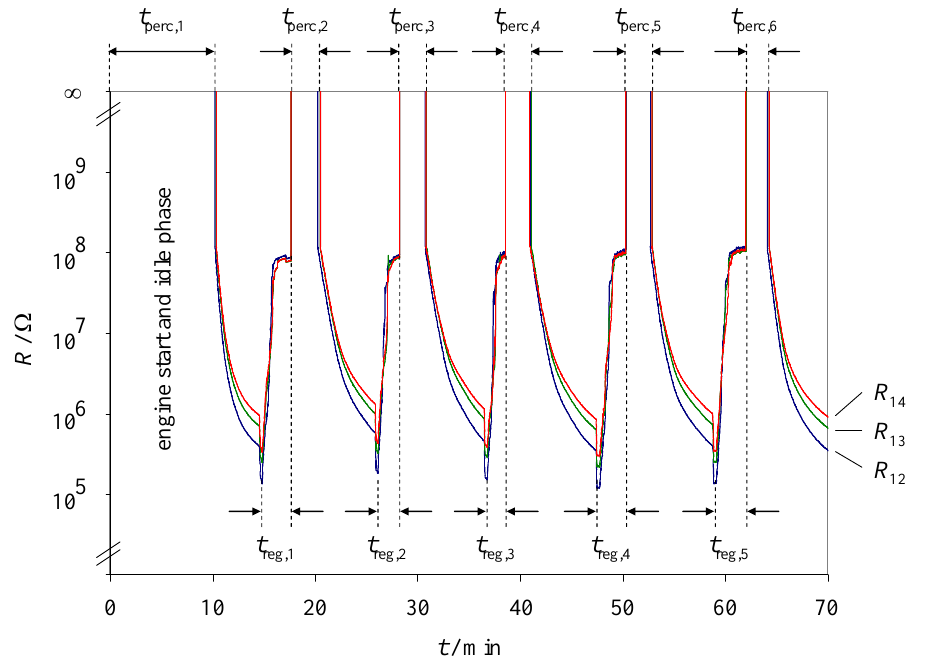
Figure 4. Resistances R were conducted at sensor position